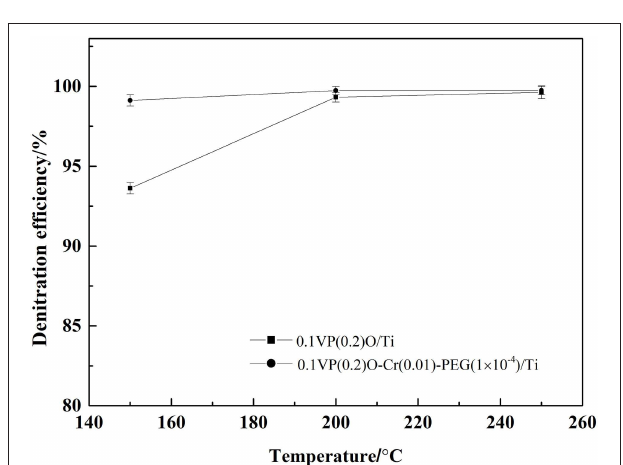
FIGURE 3 | Outlet concentration of NO x and SO 2 vs. time over 0.1VP(0.2)O/Ti catalyst.